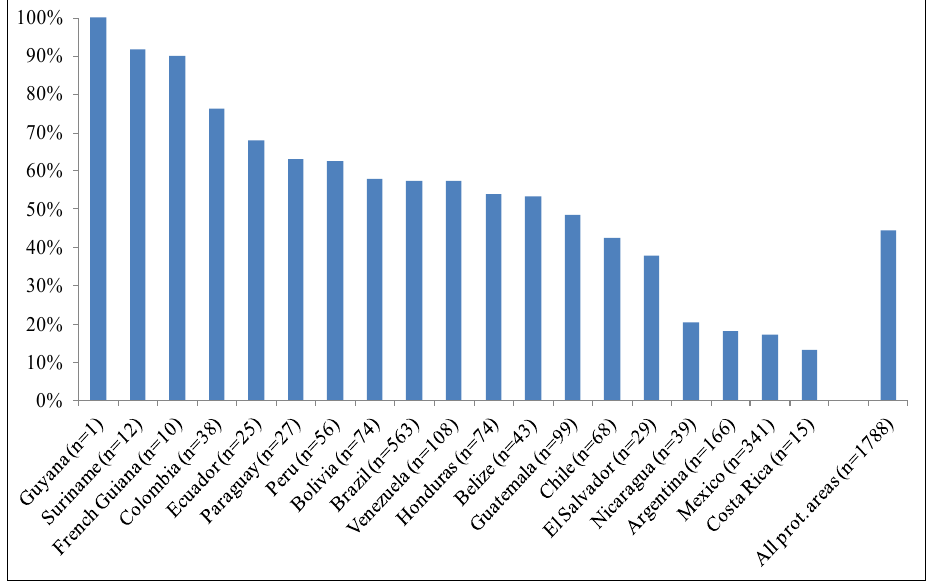
Figure 1. 2004–2009 proportion of protected areas with land and forest degradation by